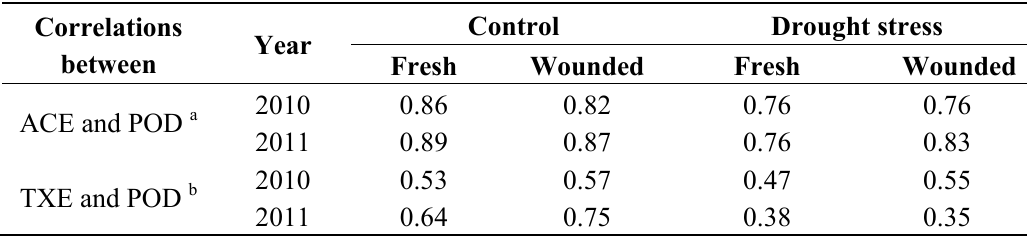
Table 9. Correlations between ACE and peroxidase enzyme (POD), and correlations between TXE and POD measured in 2010 and